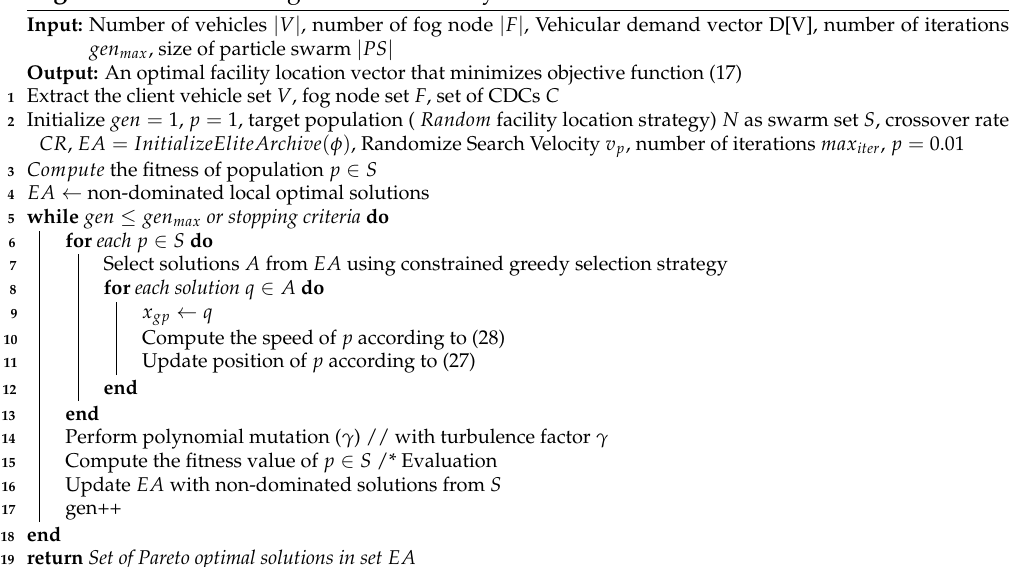
Algorithm 2 SMPSO Algorithm for facility location in